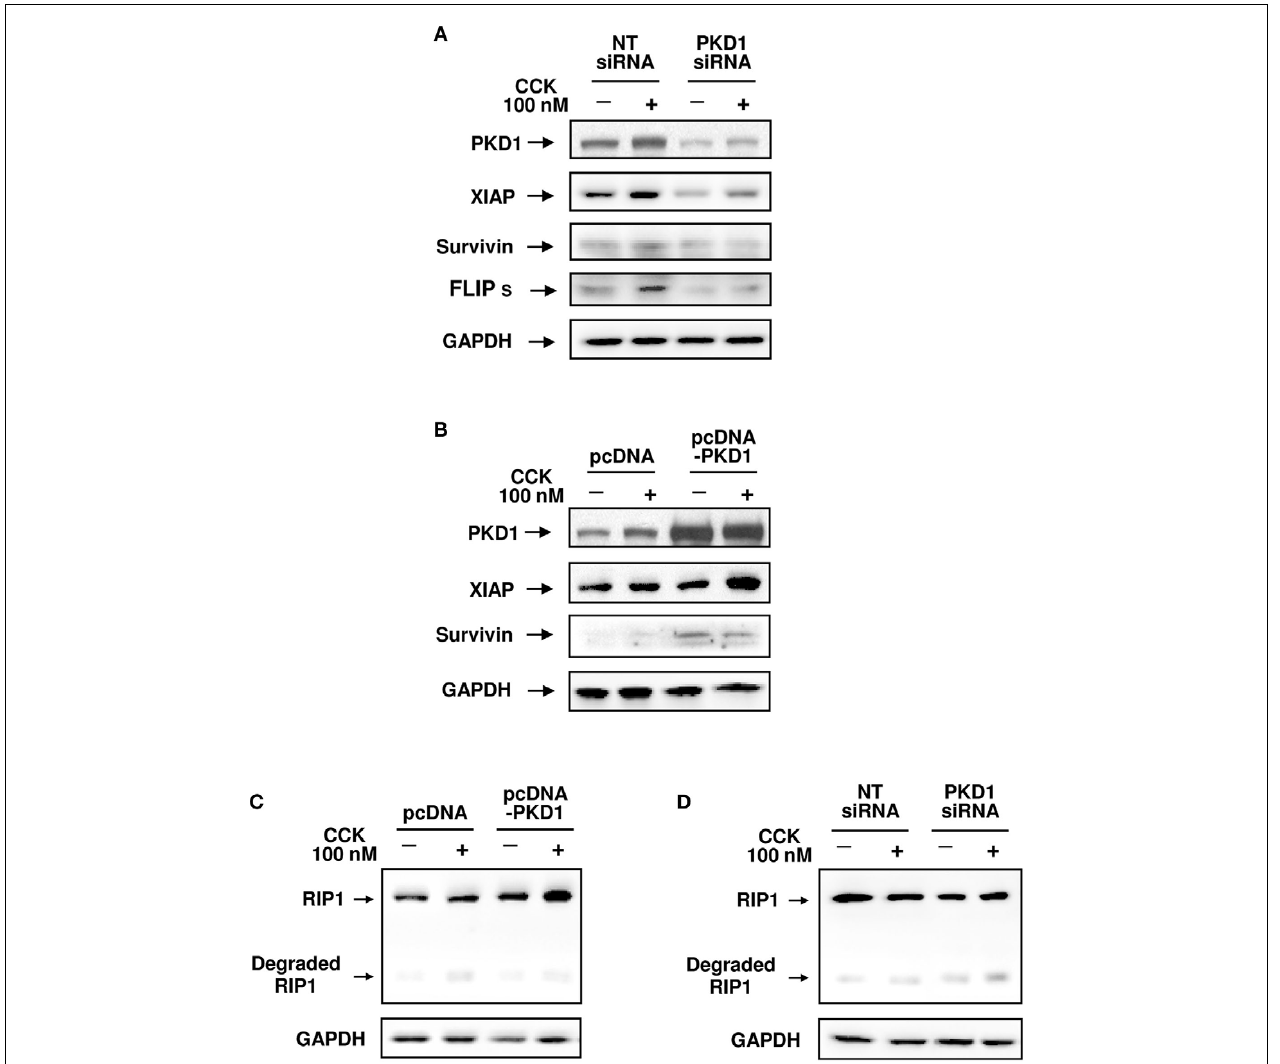
up-regulation of PKD/PKD1 expression on the protein levels of these IAPs. Blots were re-probed for GAPDH to confirm equal protein loading. Shown are representative blots from at least three independent experiments. (C,D) Western blot analysis of the cell lysates using RIP1 antibody to detect the effect of up-regulation or knockdown of PKD/PKD1 expression on RIP1 expression and cleavage.The membranes were reblotted with GAPDH antibody to verify equal loading. Shown are representative blots from three independent